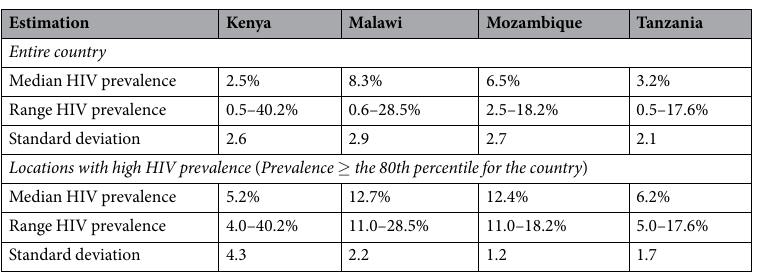
Table 2. Pixel-level HIV prevalence distribution estimations for each